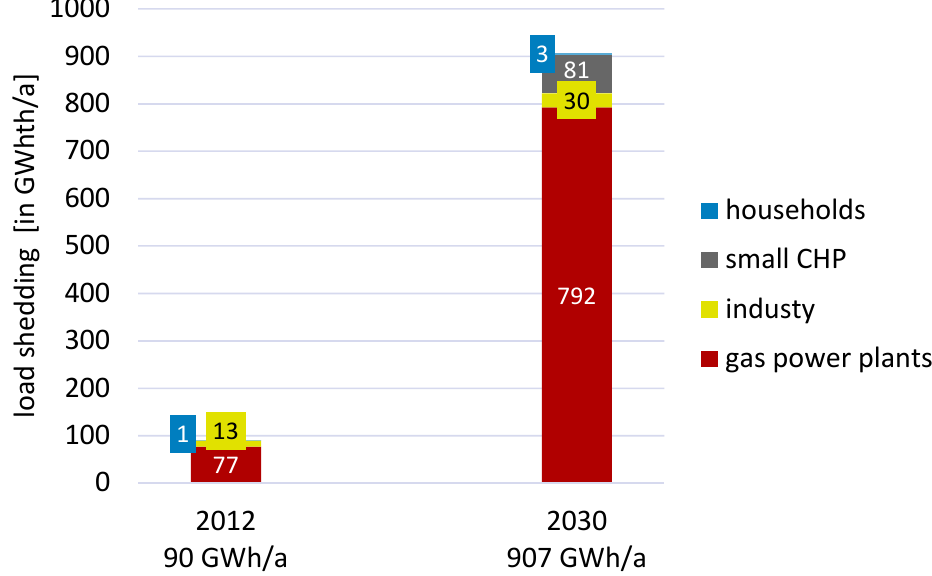
Figure 13. Results of GAMAMOD-DE for load cutoff in 2012 and 2030, clustered by gas demand sectors.